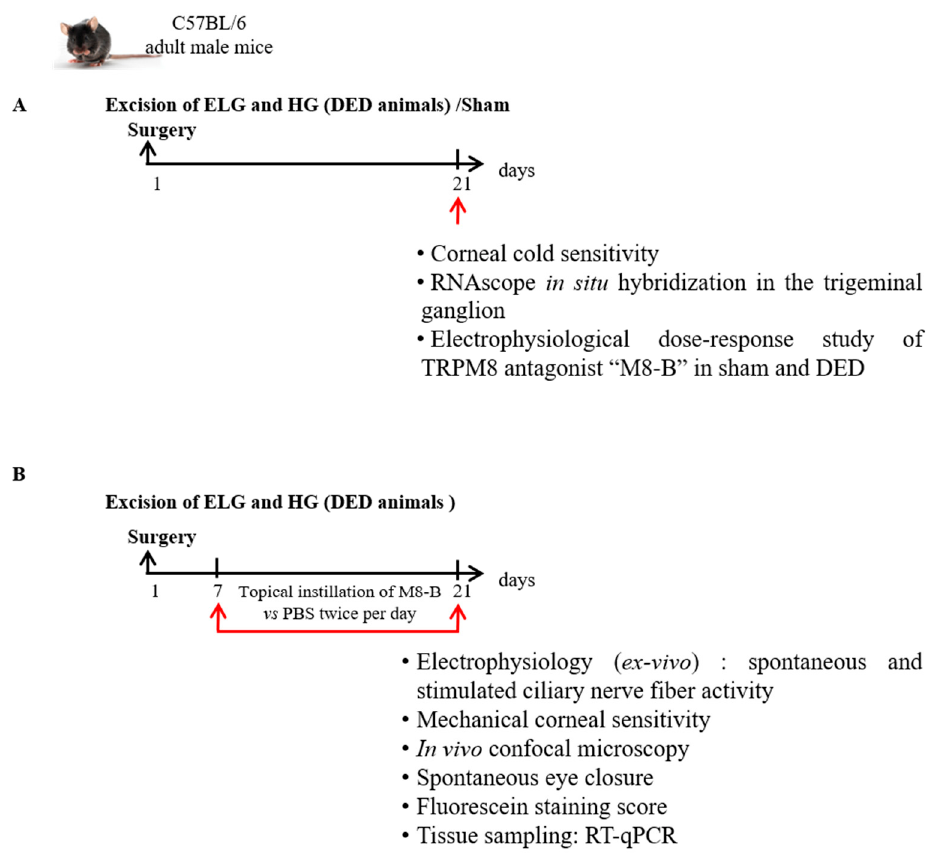
Figure 1. Research design. ( A ) Evaluation of: corneal cold sensitivity using an ocular instillation of menthol in vivo, TRPM8 mRNA expression using RNAscope in situ hybridization in the ophthalmic branch of TG and the effectiveness of acute instillation of TRPM8 antagonist M8-B at 10, 20, and 30 µM using multi-unit extracellular recording of spontaneous (32 °C) and evoked (20 °C) ciliary nerve fiber activities in DED and sham mice 21 days post-surgery; ( B ) The effectiveness of the chronic ocular M8-B instillations (twice a day from day 7 until day 21 after surgery) in the mice on: spontaneous (32 °C) and evoked (20 °C) ciliary nerve fiber activities in ex-vivo eye preparations, mechanical corneal sensitivity using von Frey test in vivo, spontaneous eye pain measuring the eye closure ratio in vivo, corneal inflammation using in vivo confocal microscopy, and mRNA expression of genes implicated in pain conduction and inflammation using RT-qPCR in DED mice instilled with M8-B (20 µM) compared to DED mice instilled with PBS.